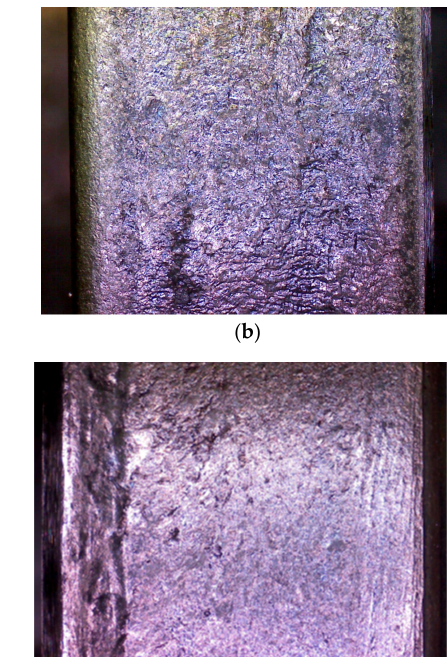
Figure 22. Comparison of fracture toughness and fatigue crack growth rate.